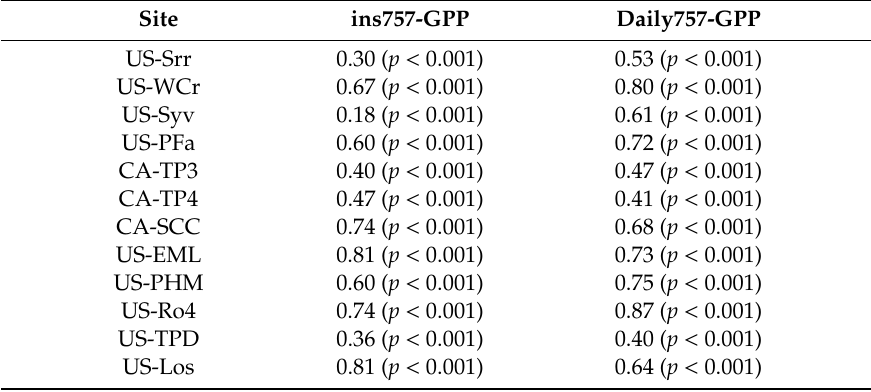
Figure 4. The linear relationship between daily SIF and daily GPP for different EC flux towers. The red circle represents the data of daily757 while the black dot represents the data of daily771. The linear relationships are presented in colorful lines for different independent variables. Table 2. Comparisons of R 2 of SIF-GPP models at instantaneous and daily scales.